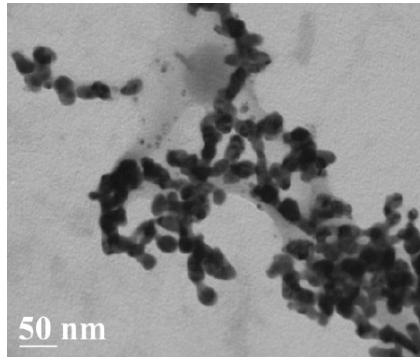
Figure 3. TEM image of Ab@AgNP bioconjugates.